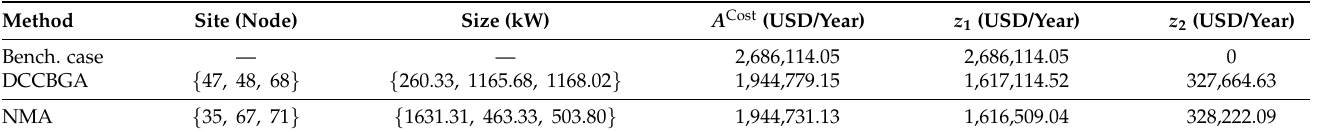
Table 5. Optimal locations and sizes provided by the GAMS and the proposed approach in the IEEE 34-bus system. Method Bench. case